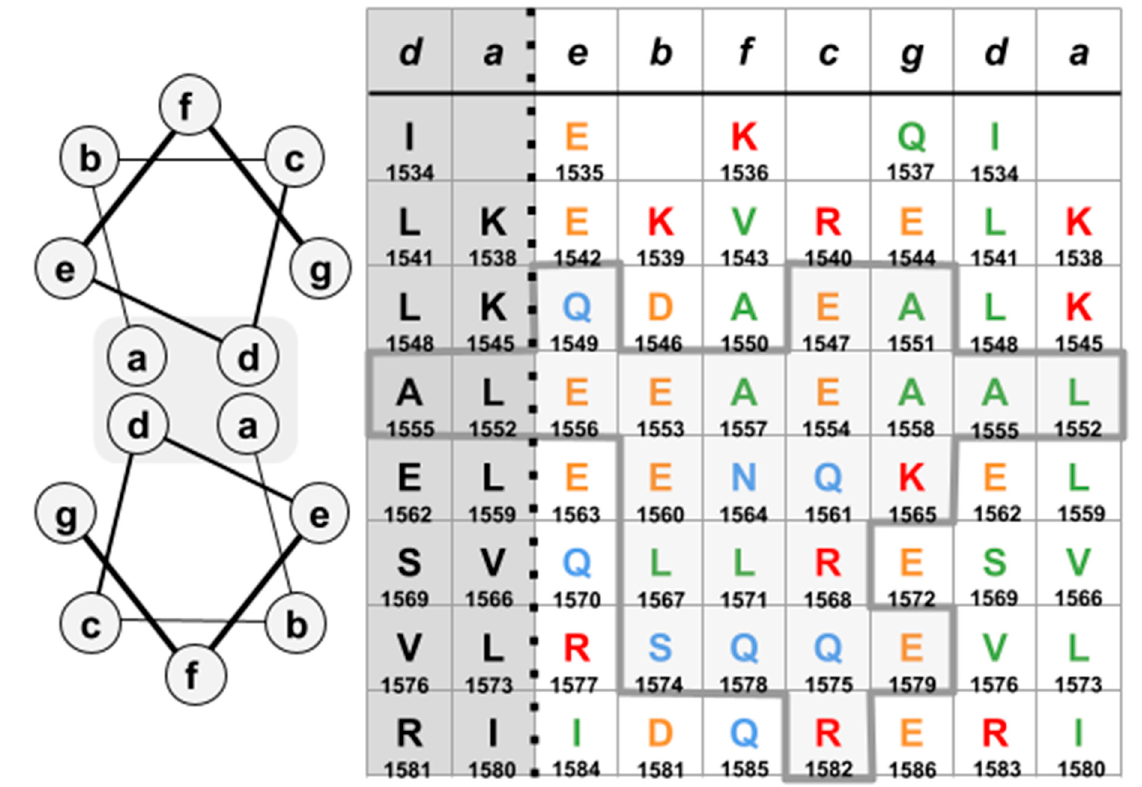
Figure 4. ( left ) Heptad position designation in a classical coiled-coil. ( right ) Interface over which red density was proximal from perspective of heptad positions (( a – g ), top row). Note ’d’ and ’a’ positions are repeated (dark shade). Thick grey lines and light shading designate the amino acids in contact with the red density.